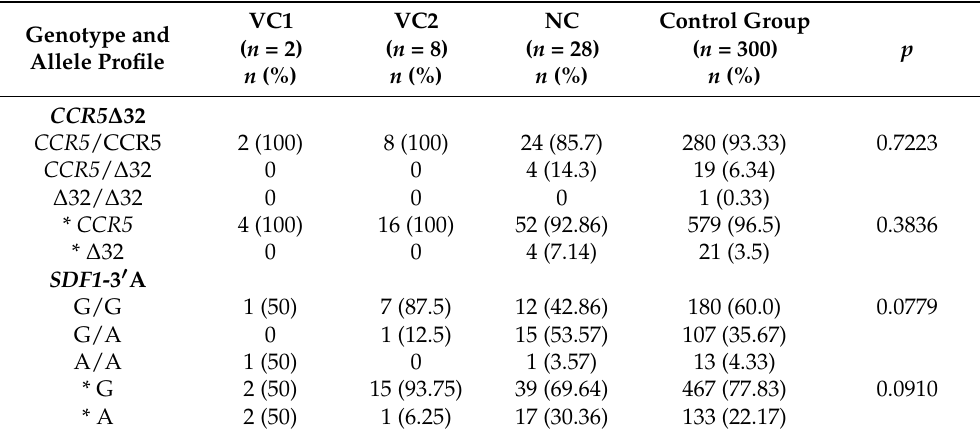
Table 2. Distributions of genotype and allele frequencies at the CCR5 ∆ 32 and SDF1-3 (cid:48) A